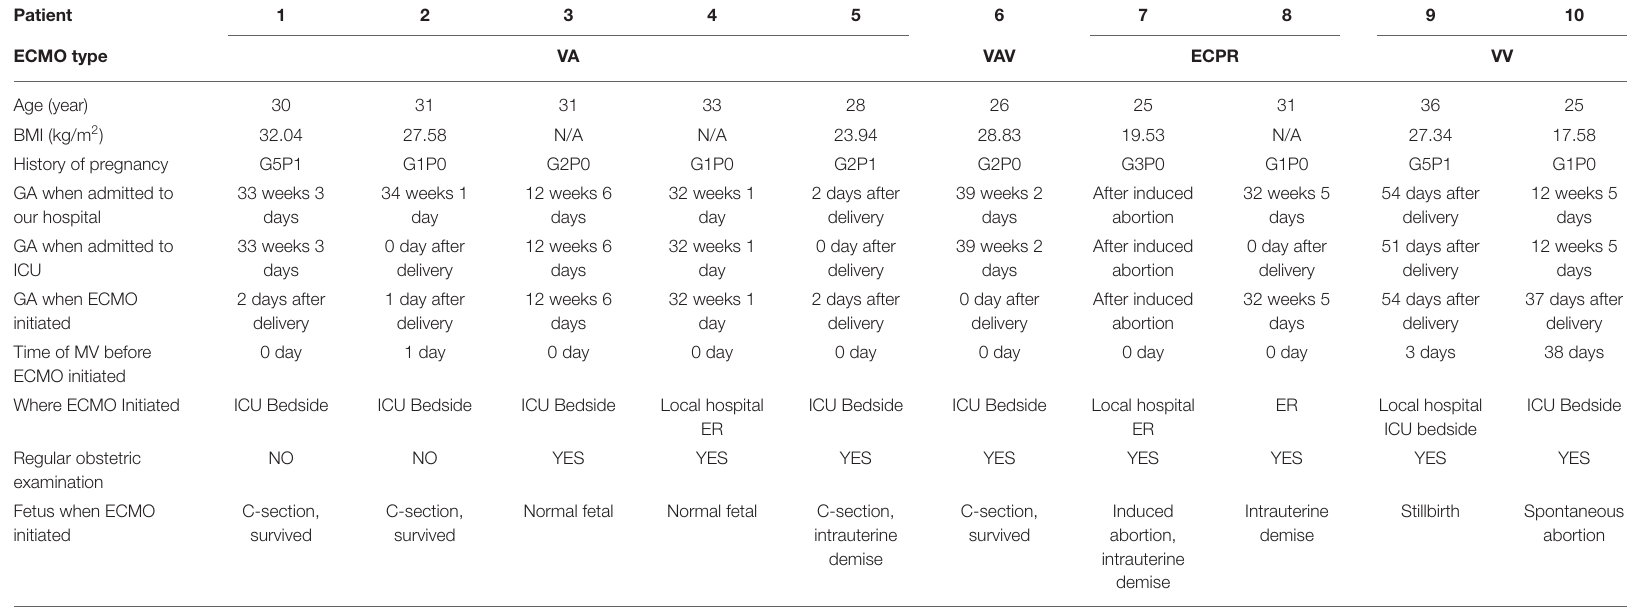
TABLE 1 | Basic characteristics of